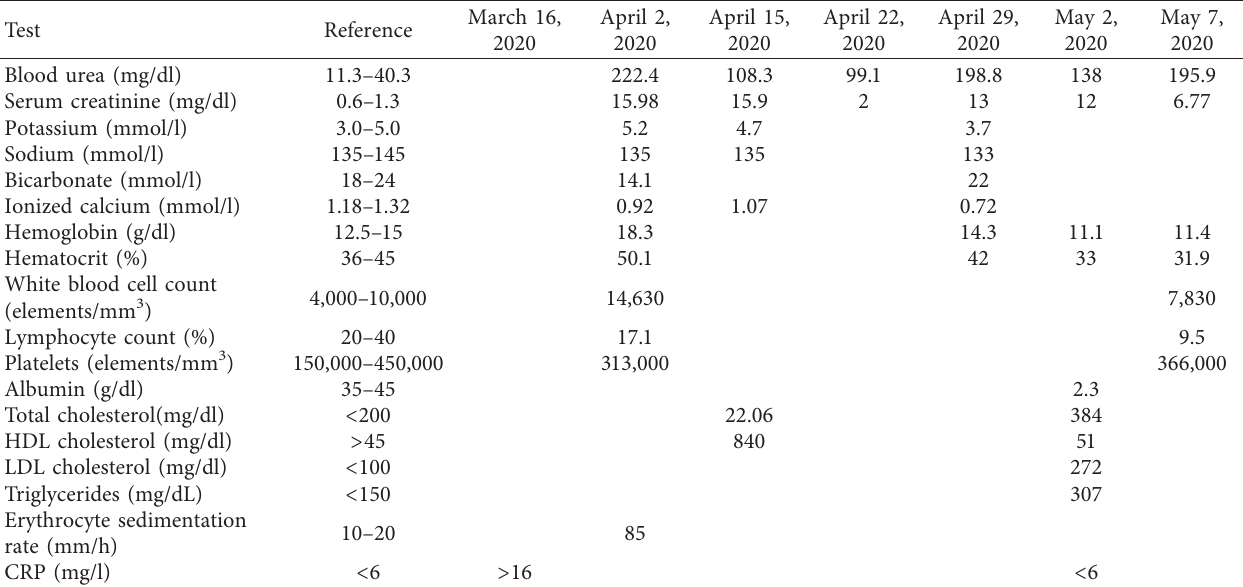
Table 1: Summary of laboratory evaluations and relevant trends during